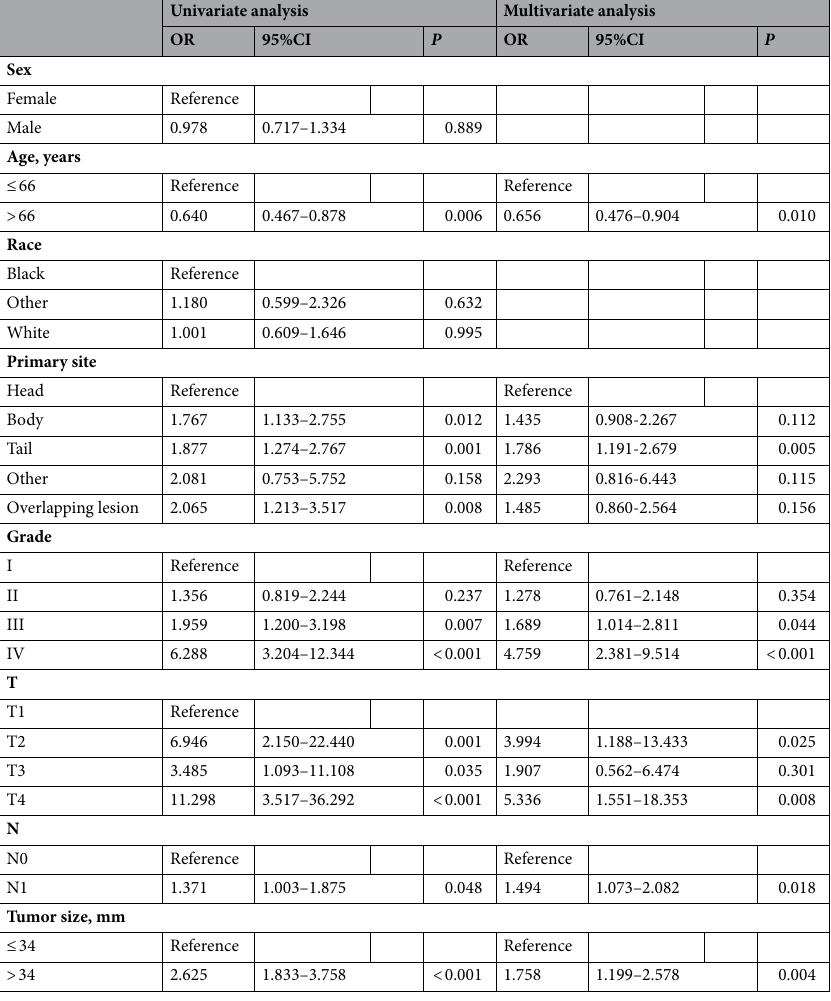
Table 2. Univariate and multivariate logistic analyses of BM in PC patients. OR: Odds ratio; CI: Confidence interval; BM: Bone metastasis; PC: Pancreatic